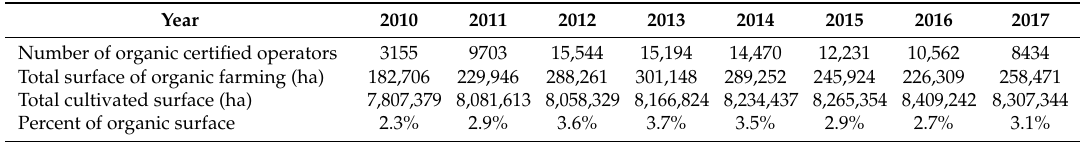
Table 1. Numerical distribution of Romanian organic certified operators between years